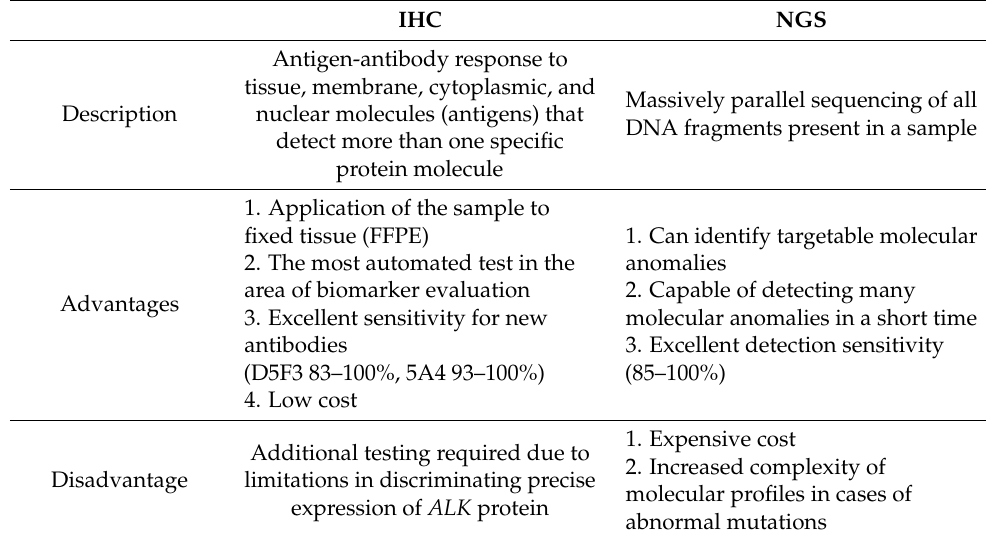
Table 1. Comparison of IHC and NGS analysis